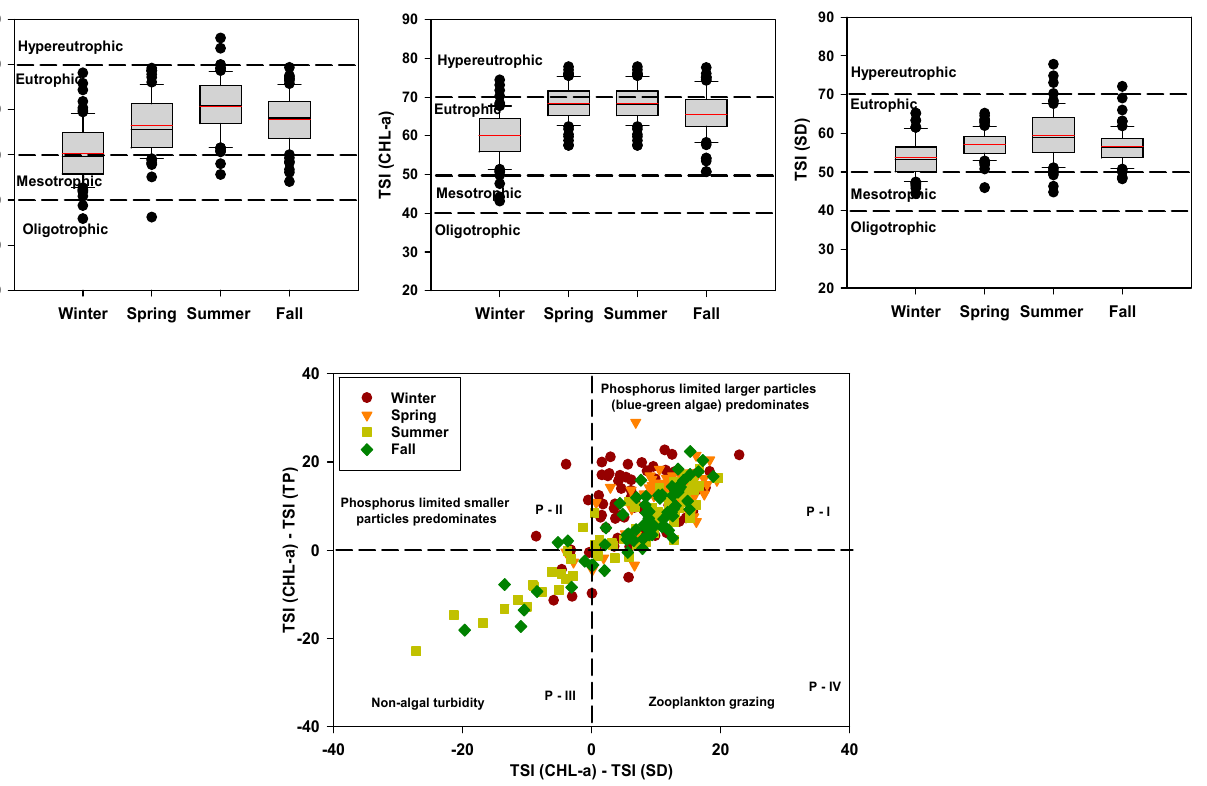
Figure 5. Seasonal Trophic State Index and its deviation.